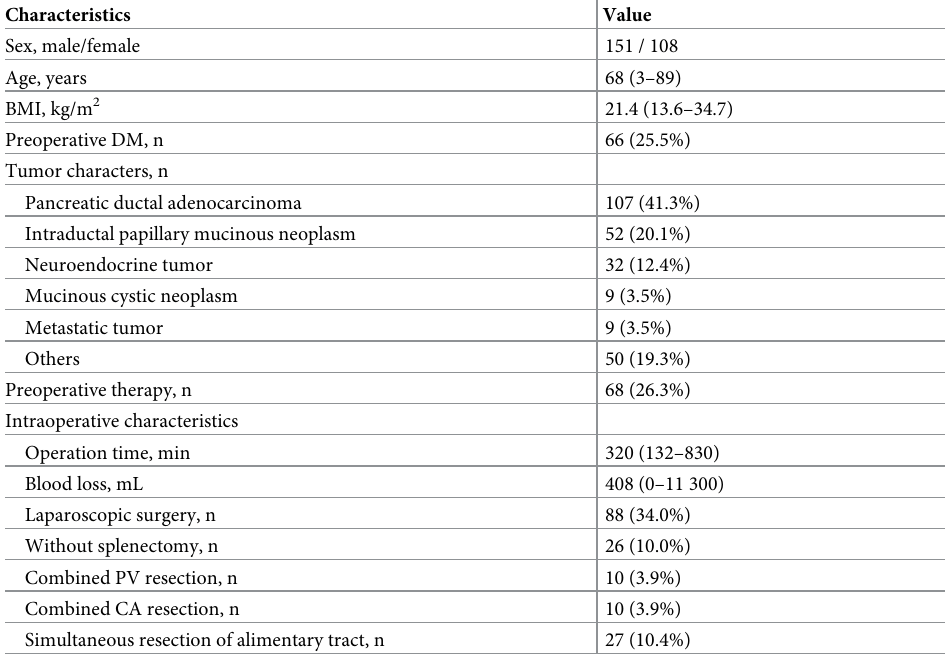
Table 1. Characteristics of patients (n = 259) who underwent distal pancreatectomy.